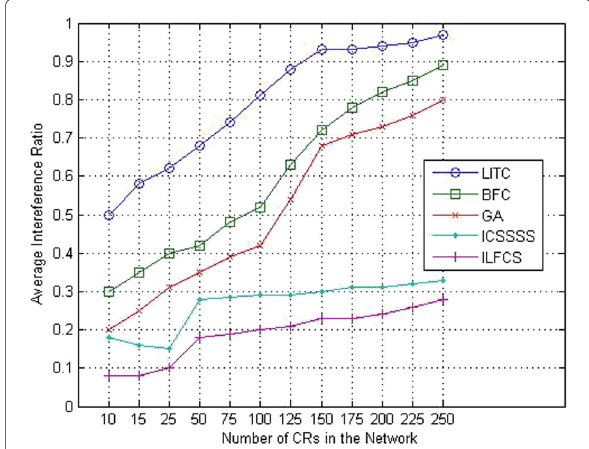
Fig. 7 Average interference ratio undervariant network density. The results of diverse simulation experiments to measure the average interference ratio at different numbers of CR nodes for the BFC, LITC, GA, ICSSSS, and the ILFCS are